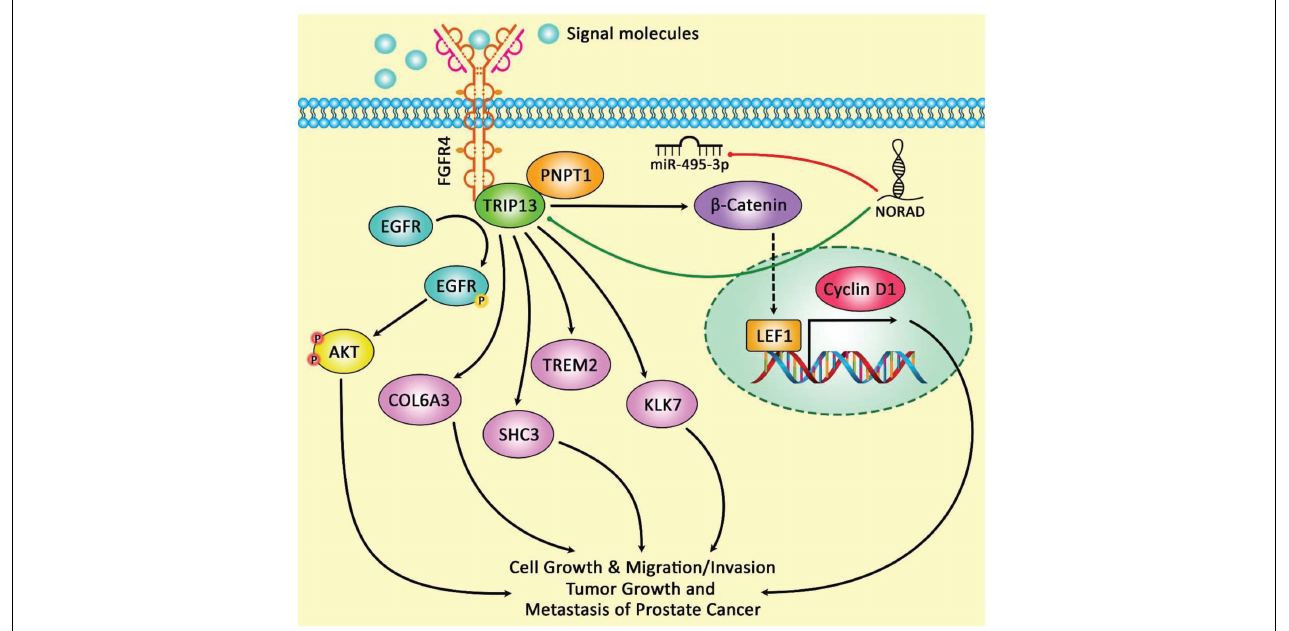
FIGURE 2 | The schematic diagram of the role of lncRNA NORAD in the regulation of TRIP13 expression in prostate cancer. Overexpression of NORAD and TRIP13 and downregulation of miR-495-3p have been in prostate cancer cells. LncRNA NORAD could modulate TRIP13 expression through sponging miR-495-3p, and thereby enhancing cell proliferation, migration, and invasion as well as reducing cell apoptosis in tumor cells. In fact, NORAD could play an important role as a sponge for miR-495-3p in prostate cancer cells that attenuates the potent tumor suppressive activity of this miRNA in target cells (Chen et al., 2020).